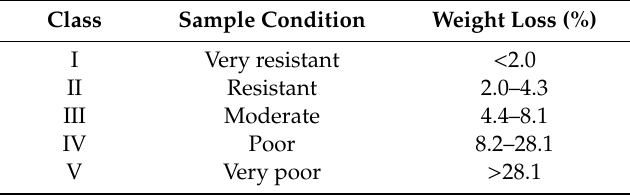
Table 2. Classification of wood resistance against dry-wood